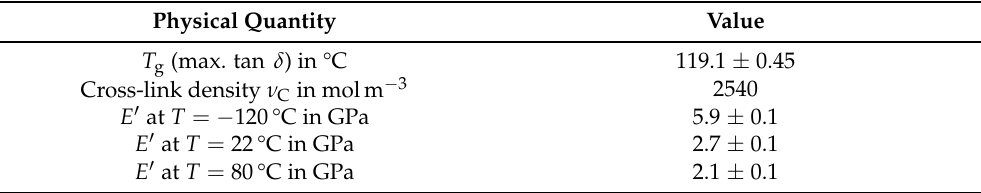
Figure 3. Dynamic mechanical analysis of Argopox between T = − 120°C and 200°C. Table 2. Key data of Argopox derived from dynamic mechanical analysis (average ± standard